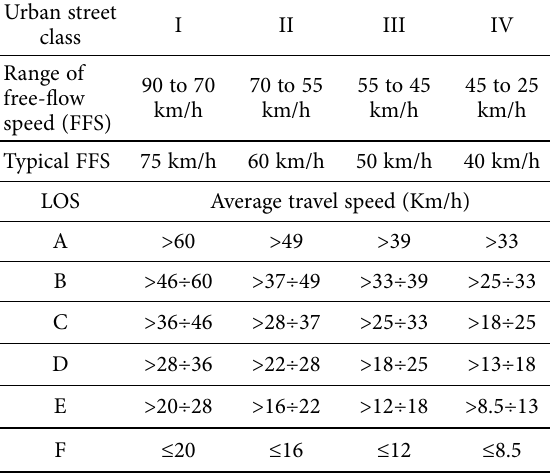
Table 1. Speed ranges of LOS categories using k -means